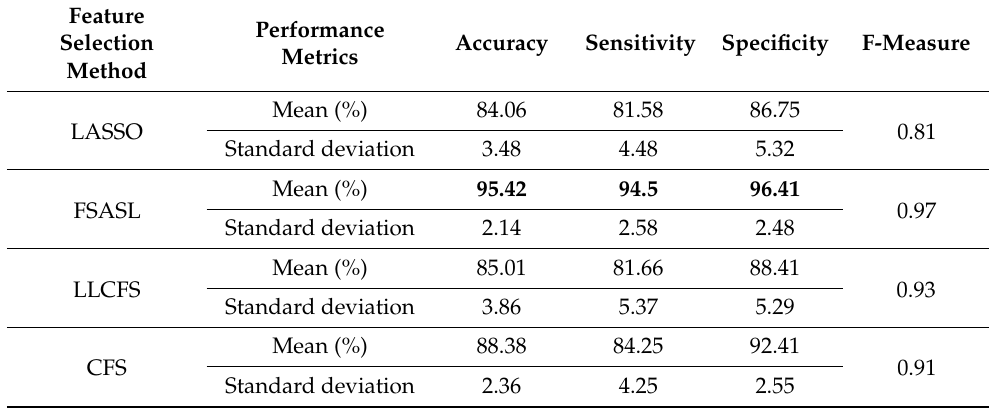
Table 5. Classification performance for AD against HC using SL-RELM classifier on large scale brain network using different feature selection methods.